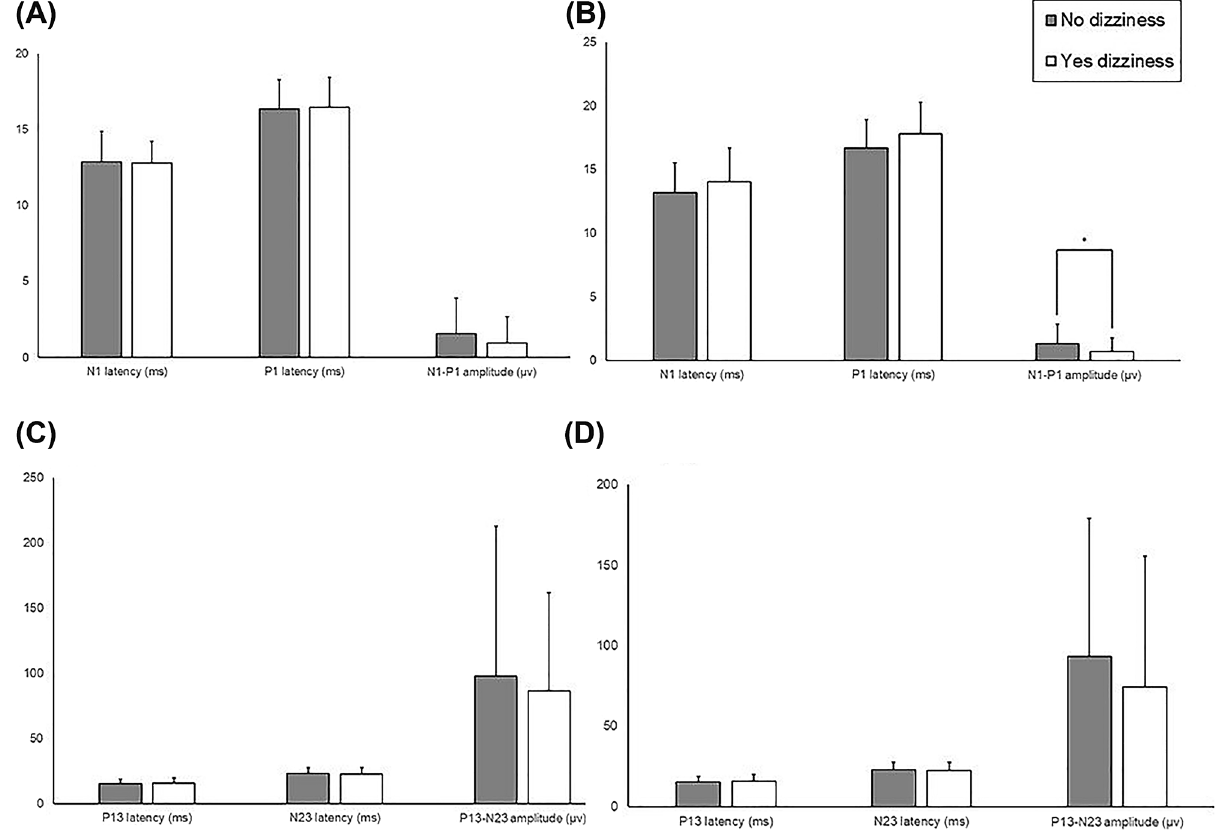
Figure 1. The latencies and peak-to-peak amplitudes of VEMPs in PD patients with and without dizziness. Ocular VEMPs in the left ( A ) and the right side ( B ). Cervical VEMPs in the left ( C ) and the right side ( D